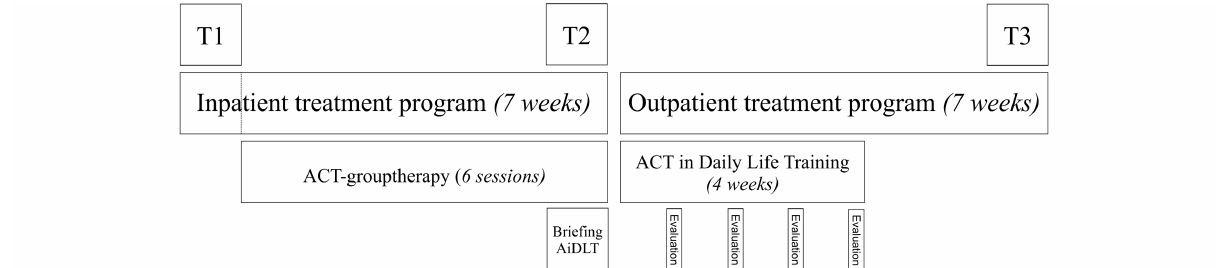
Figure 2. Timeline of the procedure for the experimental group. ACT: acceptance and commitment therapy.